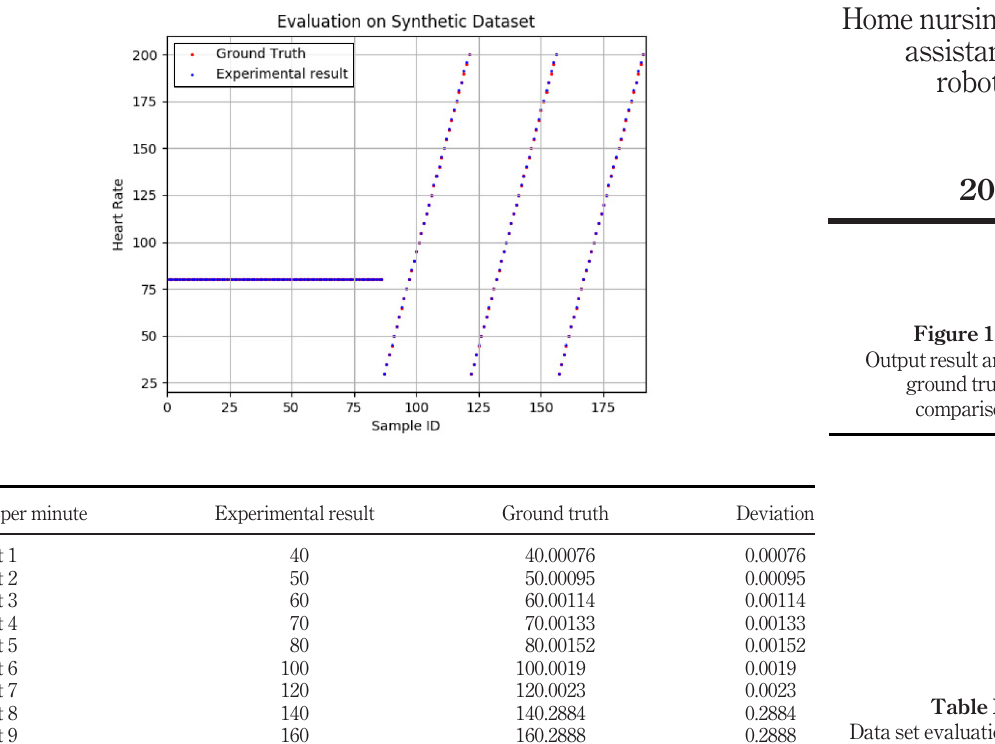
Table II. Data set evaluation